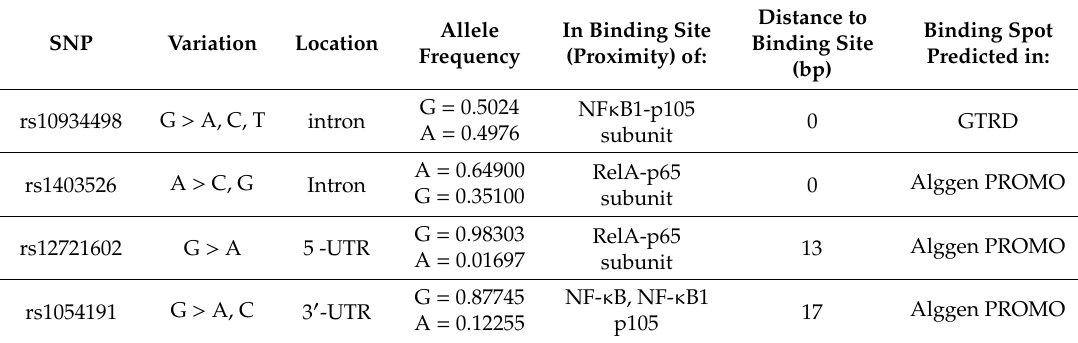
Table 2. SNPs in NR1I2 Located in A Predicted or Confirmed NF- κ B Binding Site 1